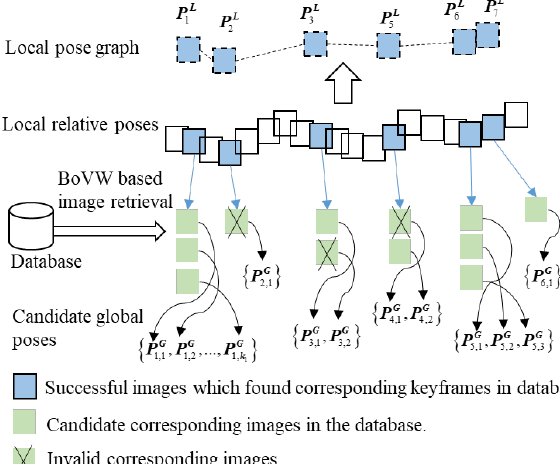
Figure 2. An illustration of local pose graph and global candidate poses after image retrieval process. After local SLAM, “local relative poses” are recovered, and then we retrieve images from database to get corresponding keyframes. The local poses of successful query images integrate “local pose